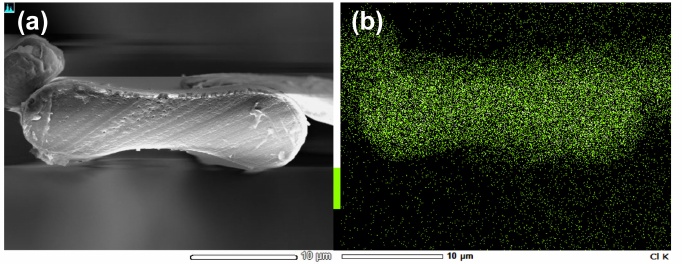
Figure 3. SEM picture ( a ) and an EDX mapping image ( b ) of regenerated silk fibroin fibers. Areas of dense green dots indicate the presence of chlorine atoms. Each picture has a 10 µ m scale bar.